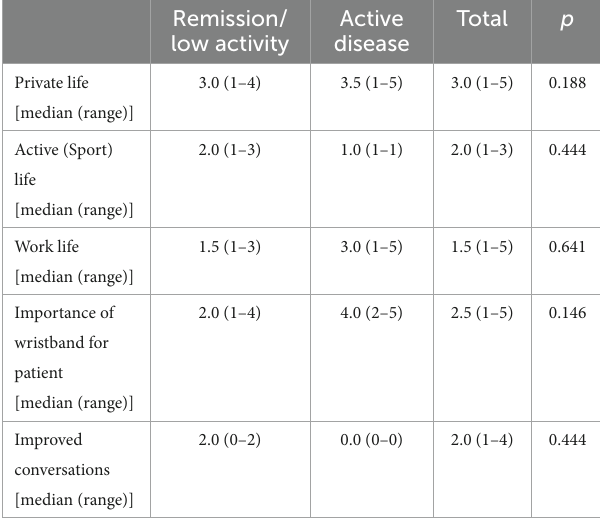
TABLE 5 Disease activity-dependent subjective effects of colored wristbands on private life, sports’ activities and work life (5 indicating the highest and 1 the lowest score of relevance).